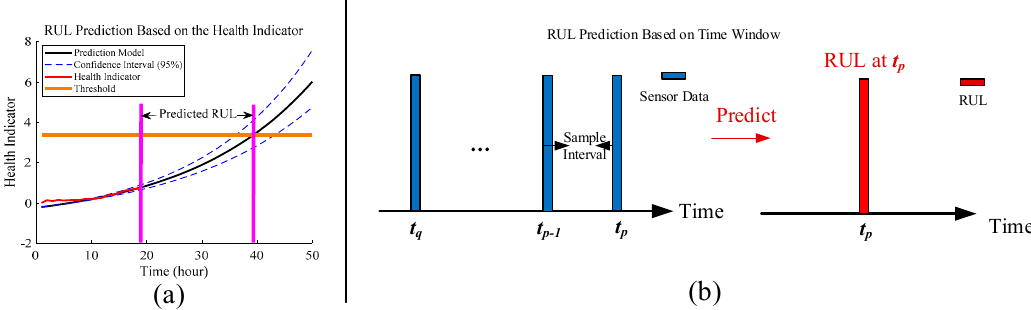
Figure 1. Remaining useful life (RUL) prediction: ( a ) Based on health indicator (HI); ( b ) based on time window.